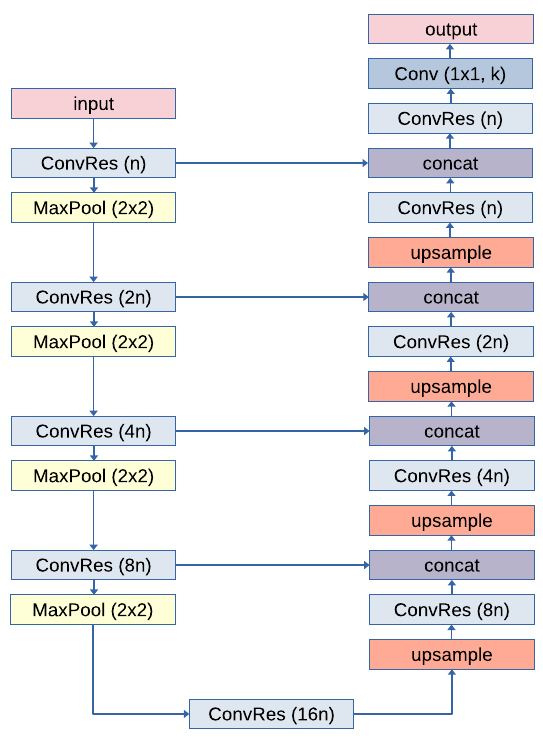
Figure 2. Architecture of the proposed neural network. ConvRes( m ) stands for ConvRes block with m filters, MaxPool ( 2 × 2 ) for max pooling layer with strides (2 , 2) , concat stands for depth-wise concatenation layer, upsample stands for 2 times upsample of tensor using transposed convolution, Conv( 1 × 1 , k) for 1 × 1 convolution with k filters, where k is the number of output channels (classes). Figure 4. Total value of pixel identification accuracy for test subset of LumenStone S1 over